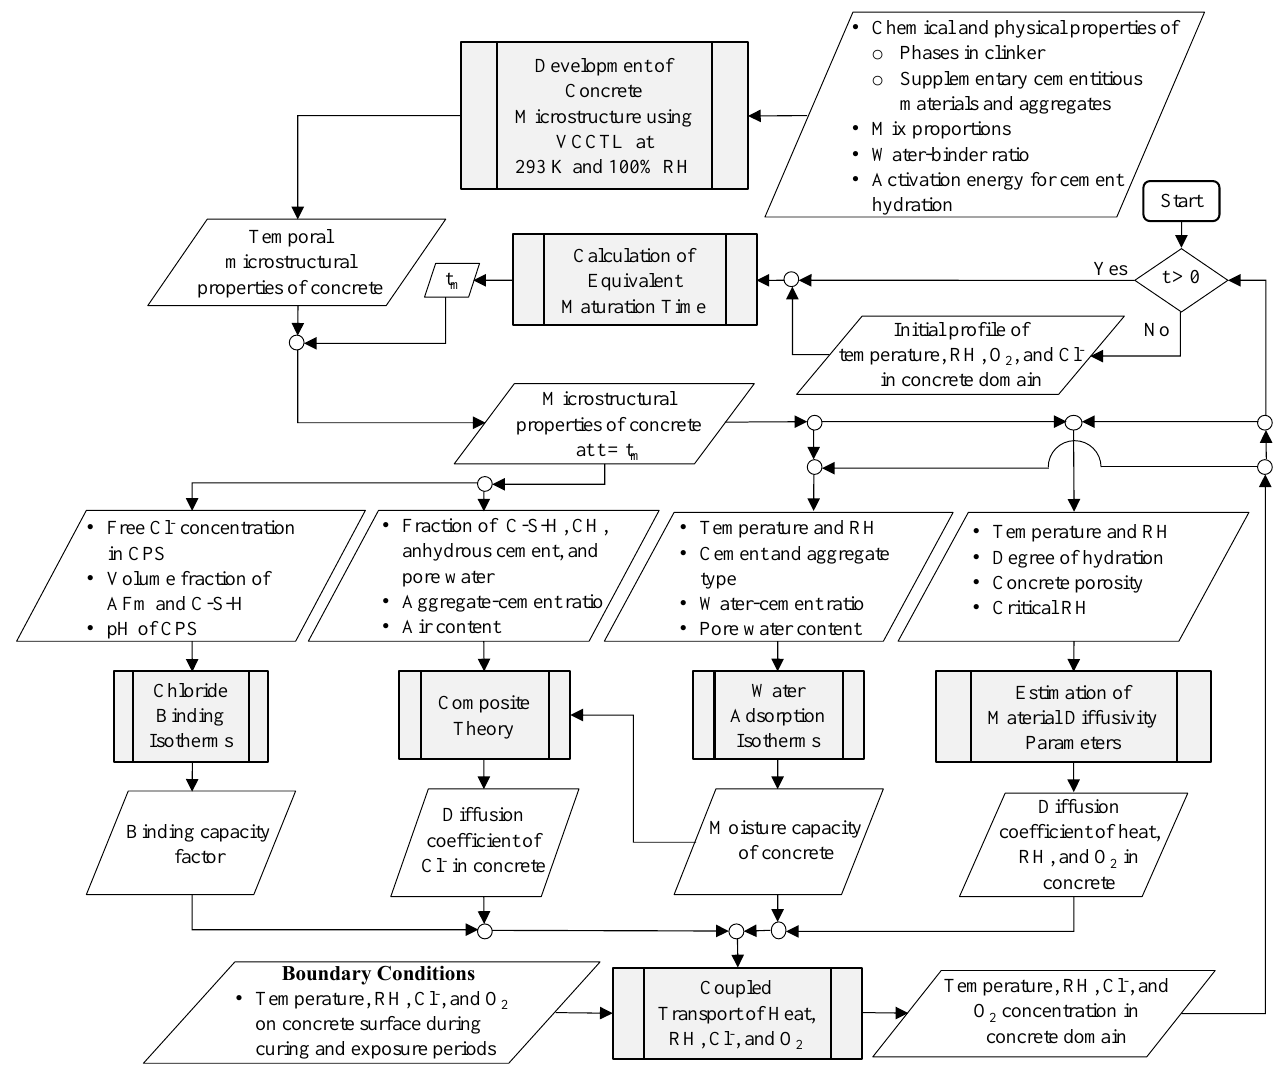
Figure 1. Flowchart of the developed model.